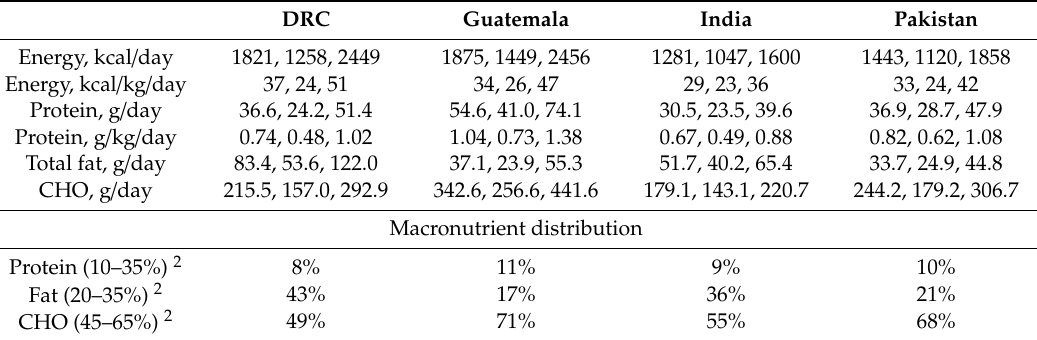
Table 2. Median, Q1, Q3 energy and macronutrient intakes 1 in four low- and middle-income countries by site and comparison to the acceptable macronutrient distribution range (AMDR) 2 .